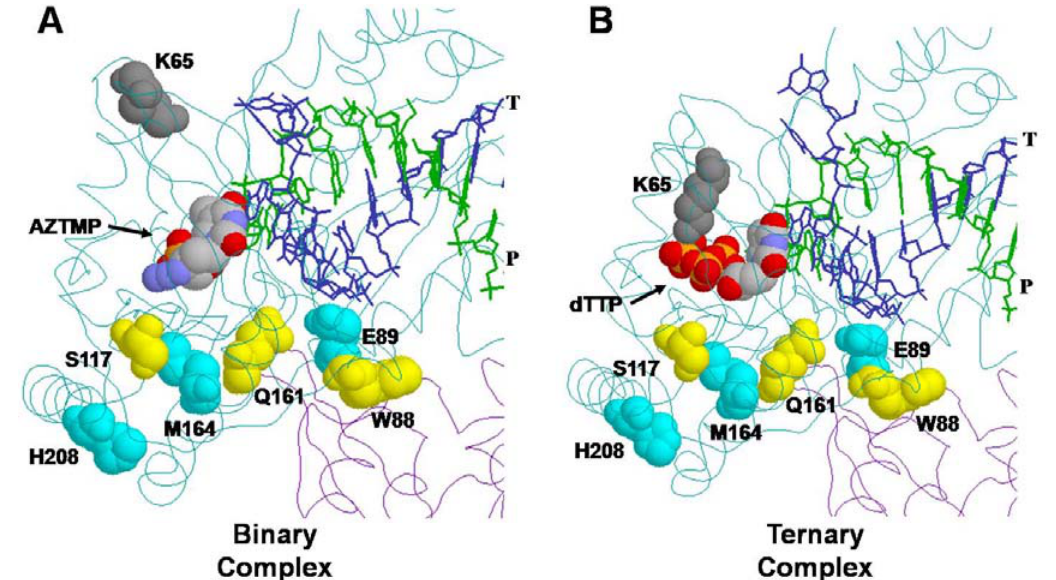
Figure 2. Locations of residues altered by PFA-resistance mutations in the structures of binary and ternary complexes of HIV-1 RT. (A) Binary complex of HIV-1 RT with AZTMP-terminated primer-template occupying the dNTP-binding site (N site) [PDB structure 1N6Q, Ref. 45]. (B) Ternary complex of HIV-1 RT with ddAMP-terminated primer-template and dTTP occupying the N site [PDB structure 1RTD, Ref. 85]. The template (T) is shown in blue, and the primer strand (P) in green. The structure occupying the N site in each complex is shown as a space-filling model (atoms indicated by CPK color scheme). Residues that are substituted in the indicated PFA-resistant mutants are also shown as space-filling models. The fingers-domain residue K65 is shown in gray. Palm- domain residues are shown in yellow or cyan using contrasting colors to distinguish overlapping structures